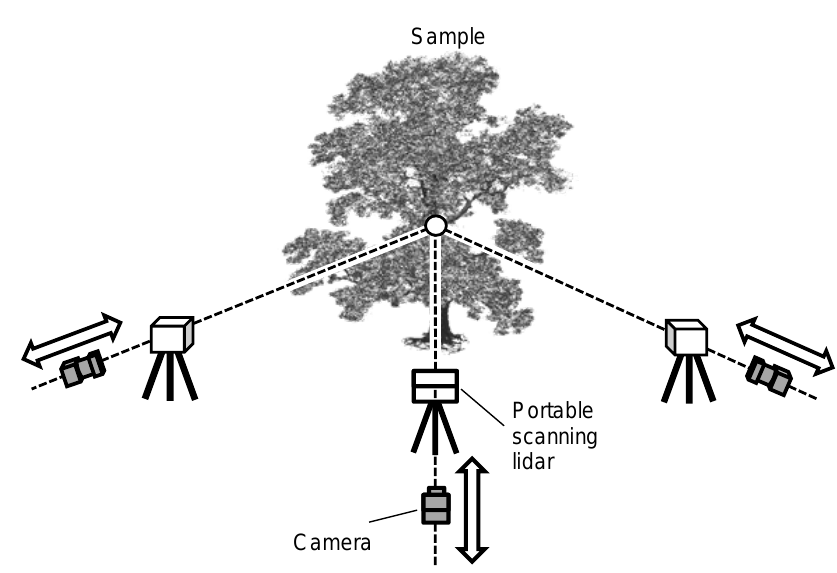
Figure 1. Schematic illustration of the positional relation of a camera and portable scanning lidar.